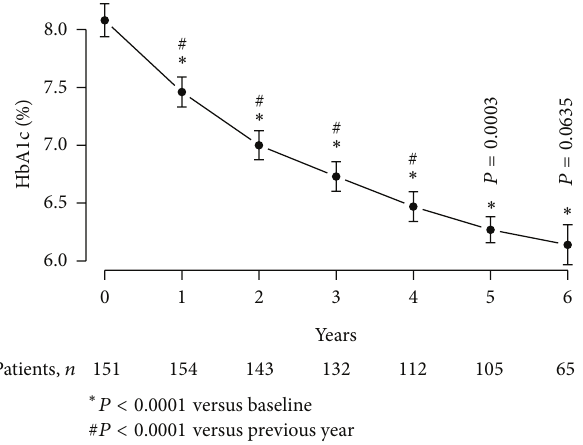
Figure 6: HbA 1 (%) in 156 obese hypogonadal men with type 2 c diabetes treated with testosterone undecanoate injections for up to 6